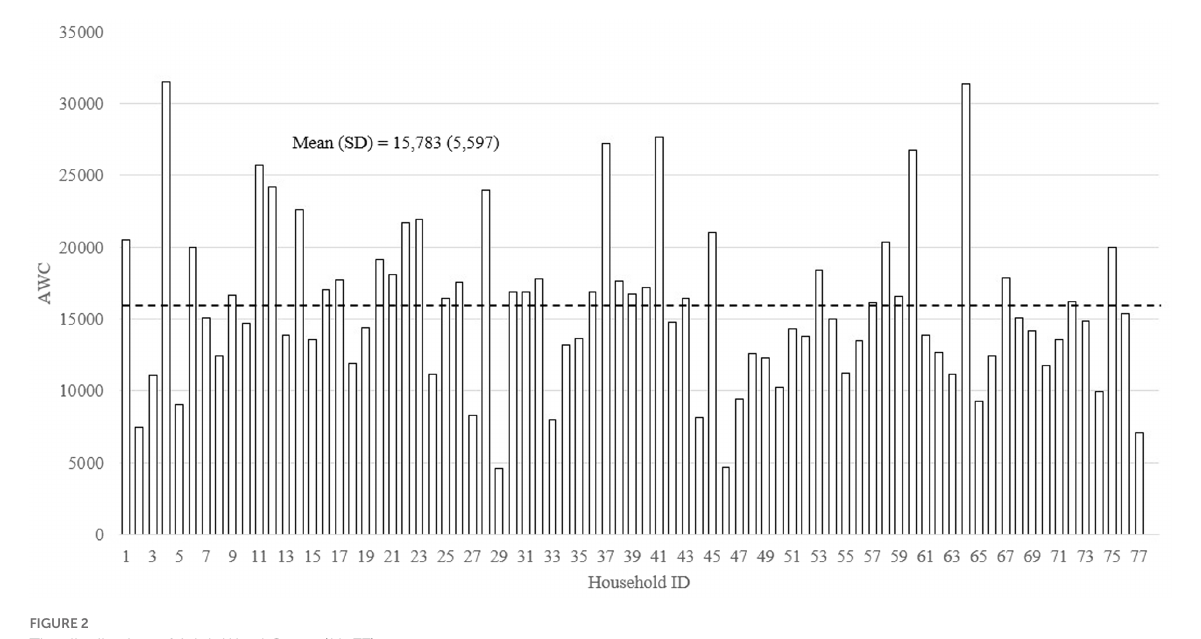
FIGURE 2 The distribution of Adult Word Count ( N =